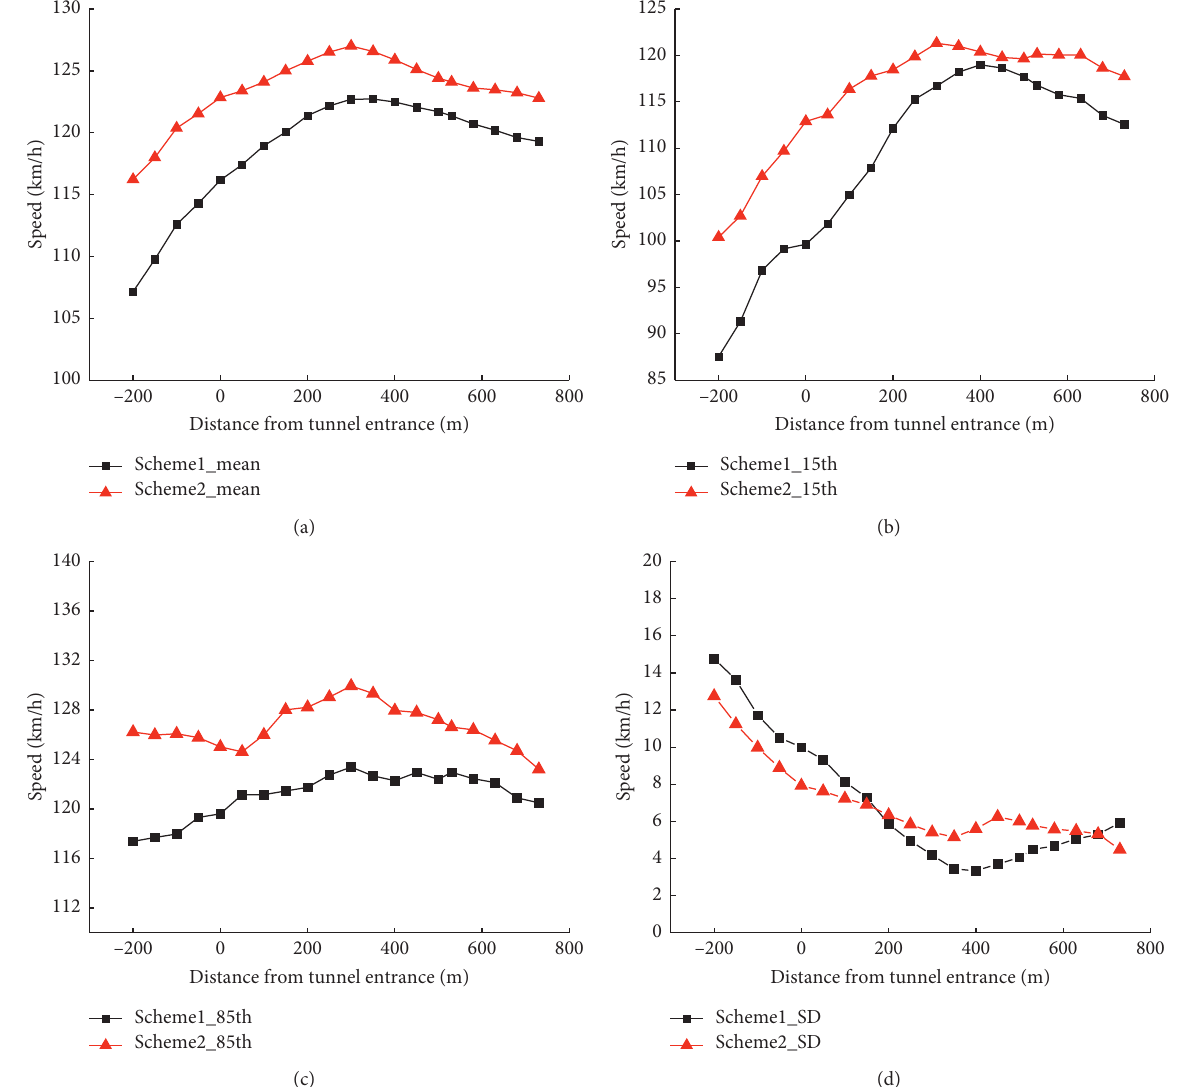
Figure 4: Variation of speed indicators for different left lateral